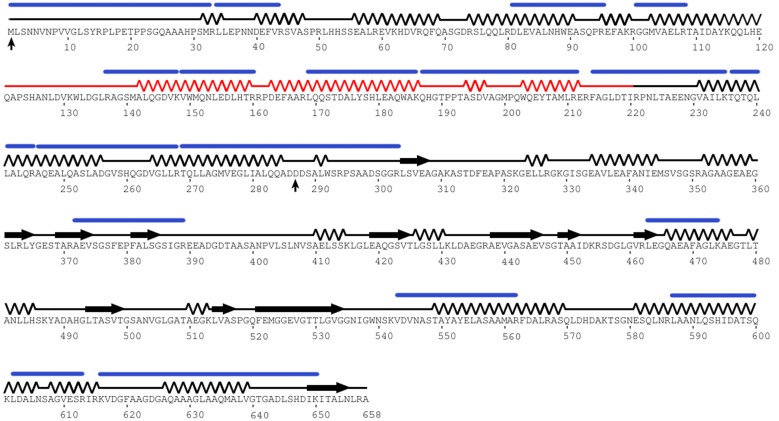
Secondary structure prediction of BteA superposed on established experimental data.The sequence of BteA was subjected to secondary structure meta-server analysis which was plotted as line for coil, spring for alpha-helix and arrow for beta sheet. Vertical arrows mark the boundaries of BteA287 fragment. Experimentally-derived secondary structure topology (PDB code 2JPF, aa 121–220) is shown in red. BteA-derived peptides from peptide fingerprinting MS/MS experiment (see Materials and Methods) were plotted as blue lines.